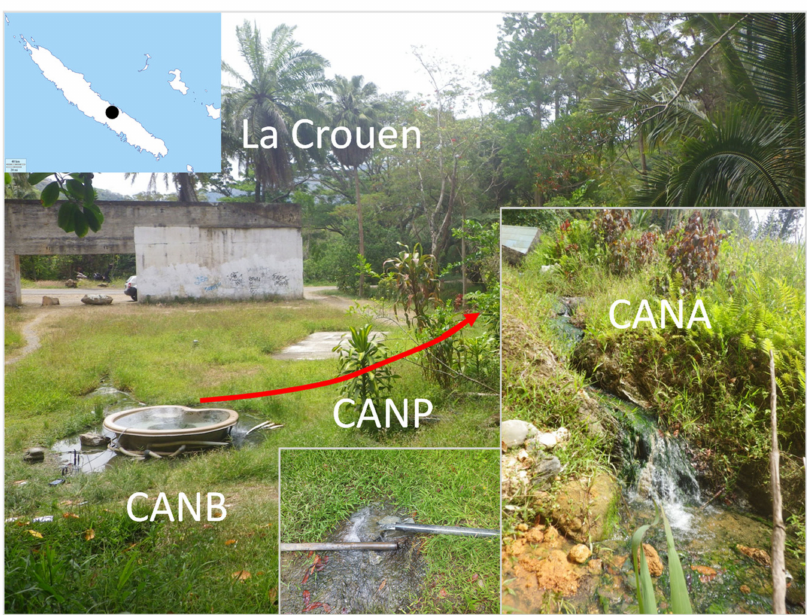
Figure 1. Location and photographs of the alkaline spring of La Crouen spring (New Caledonia). Photographs show the Scheme 100 mL glass bottles sealed with butyl stoppers. For molecular micro- bial community analysis, both waters and sediments were collected in duplicate at CANB, CANP, and CANA. Surface sediments were sampled with a sterile spatula and collected into sterile Falcon tubes. Water samples were collected in cleaned 4 L plastic bottles. Both water and sediment samples were stored in a portable icebox until arrival at the laboratory (about two hours after sampling). Two liters of water were filtered in duplicate through 0.2 µ m pore-size Isopore polycarbonate membrane filters (Millipore). The filters and sediments were kept at − 80 ◦ C before DNA extraction. A sterile glass bottle was also filled in the field with the sediment slurry, then hermetically sealed to prevent oxidation, and stored at 4 ◦ C before